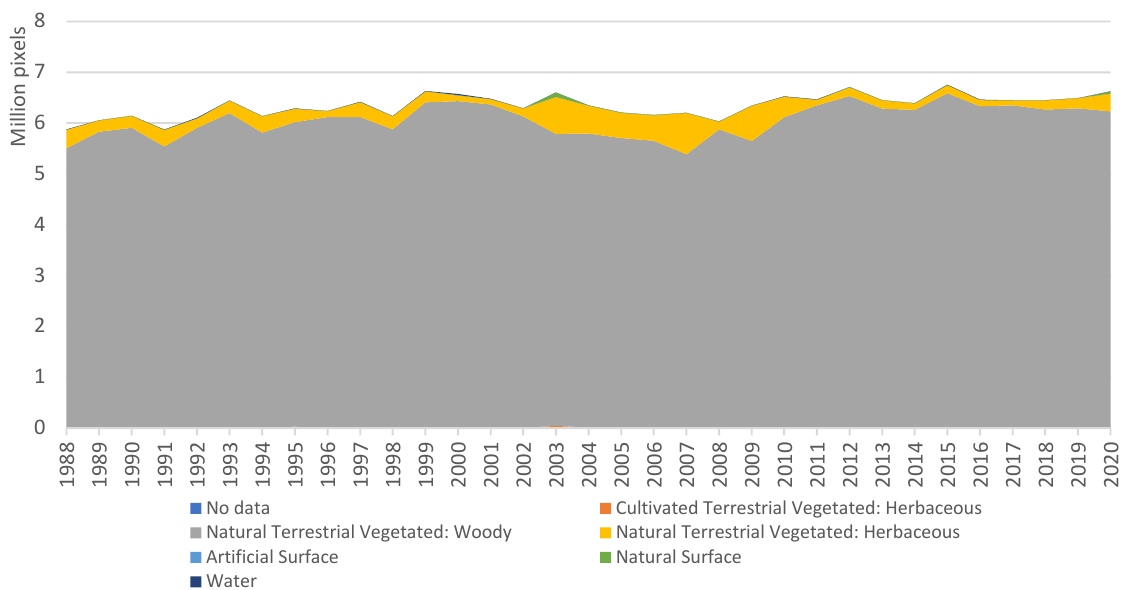
Figure 7. DEA Land Cover classes that correspond to the U-Net CNN model Forest and Plantation classes.